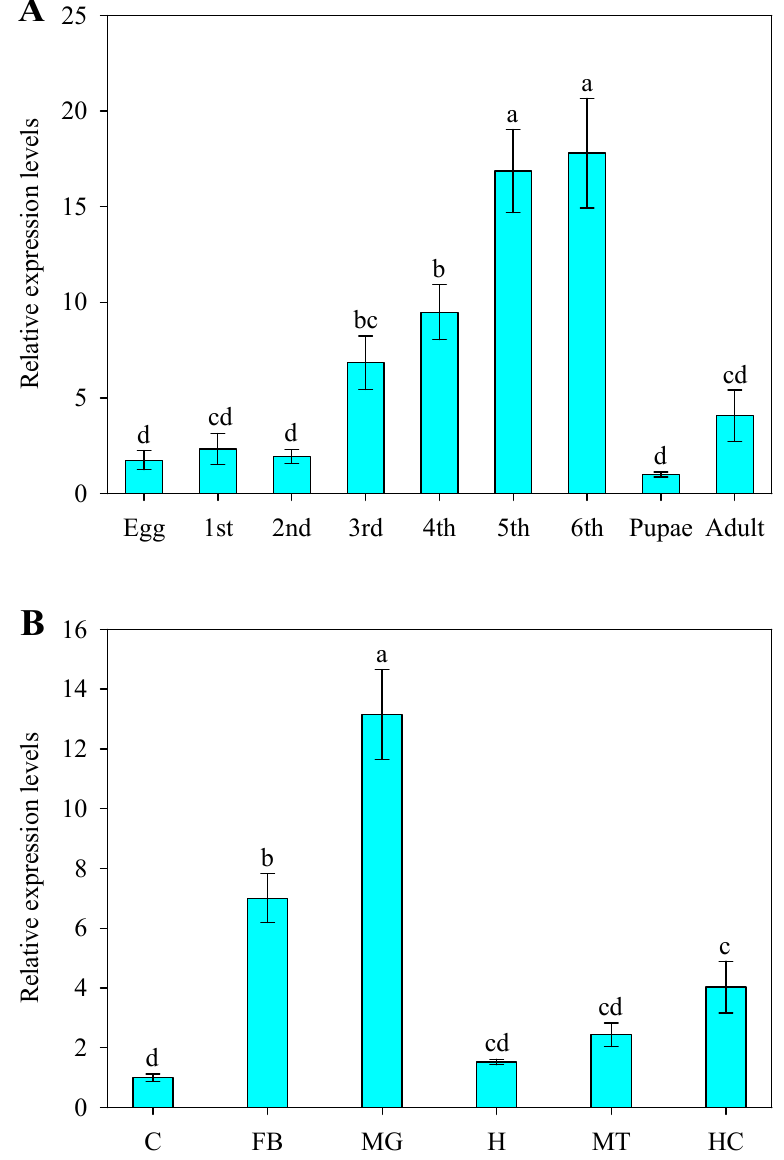
Figure 3. Relative expression levels of SlCPR at different development stages ( A ) and in various tissues ( B ). Whole body of S. litura larvae were used for the different development stages, while fifth-instar larvae were used for various tissues. Expression levels of SlCPR were determined by quantitative reverse transcriptase PCR (RT-qPCR), and β -actin and EF1 were selected as reference genes. Each RT-qPCR reaction for each sample was performed in three biological replicates and three technical replicates. Data shown are means ± SE. Different letters (a,b,c,d) above bars indicate significant differences ( p < 0.05) according to Duncan’s multiple range test. Abbreviations: 1st to 6th—first- to sixth-instar larvae; C—cuticle; FB—fat body; MG—midgut; H—head; MT—Malpighian tubule; HC—hemocytes.